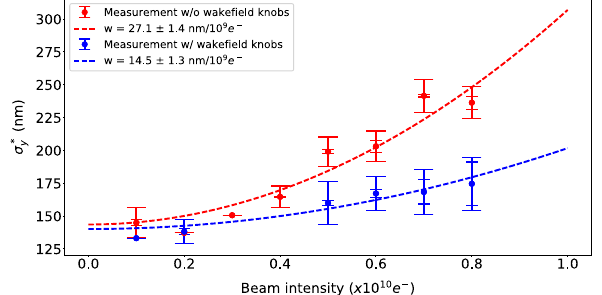
FIG. 17. Measured vertical IP beam size ( σ (cid:1) y ) vs the beam intensity before (red) and after (blue) applying wakefield knobs. For each experimental data point the longer error bar shows the quadratic sum of the statistical and the systematic errors and the shorter error bar shows the systematic error. The lines show fits of Eq.